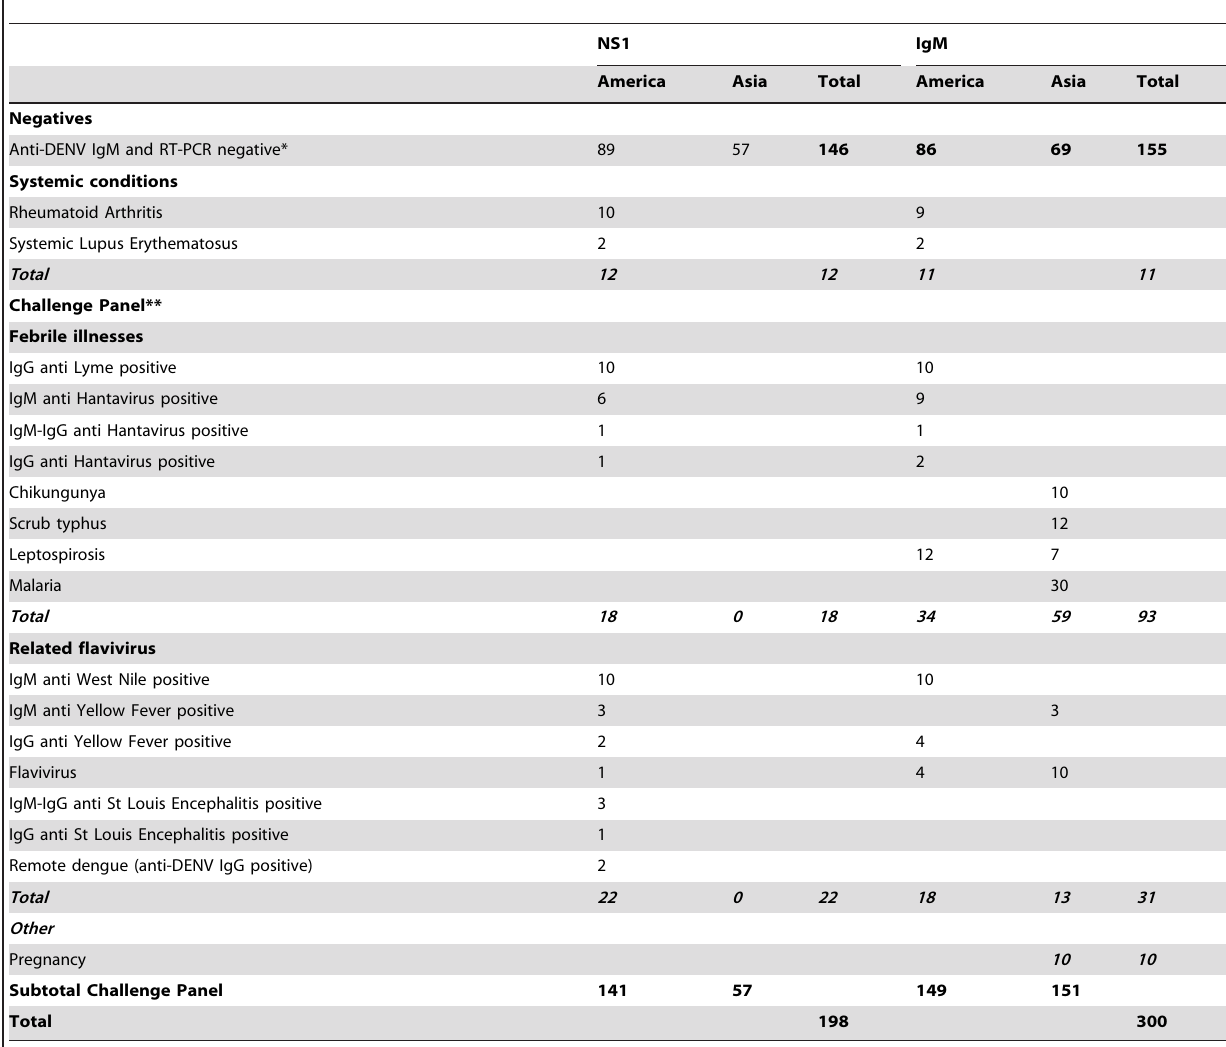
Table 4. Characteristics of DENV negative specimens and challenge specimens for the evaluation of NS1 and anti-DENV IgM